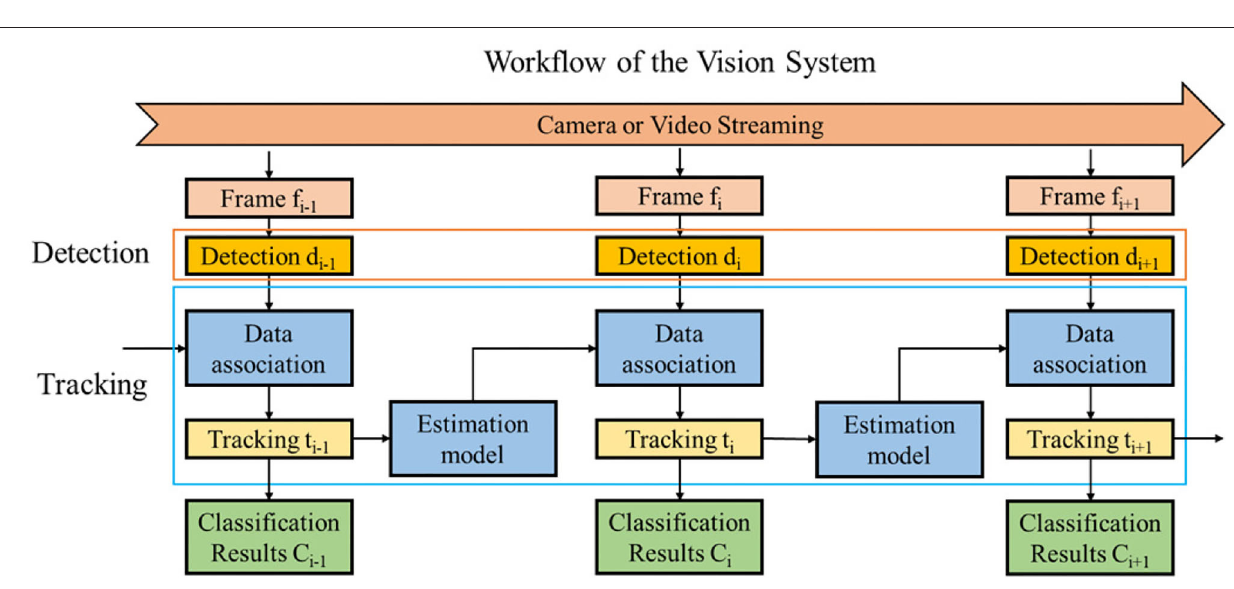
track and record the classification information of each orange on its path within the working space. The vision system could then classify the true categories of each orange based on the historical classification